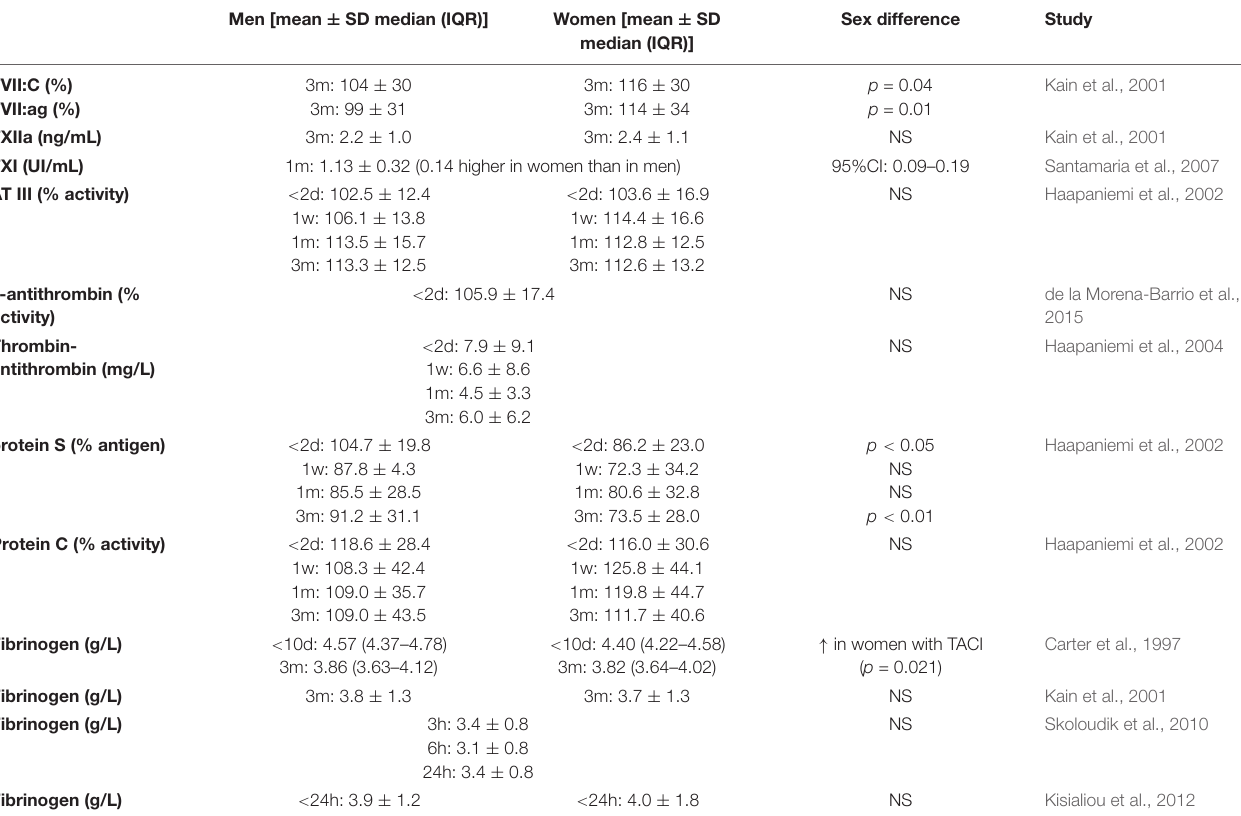
TABLE 2 | Secondary hemostatic